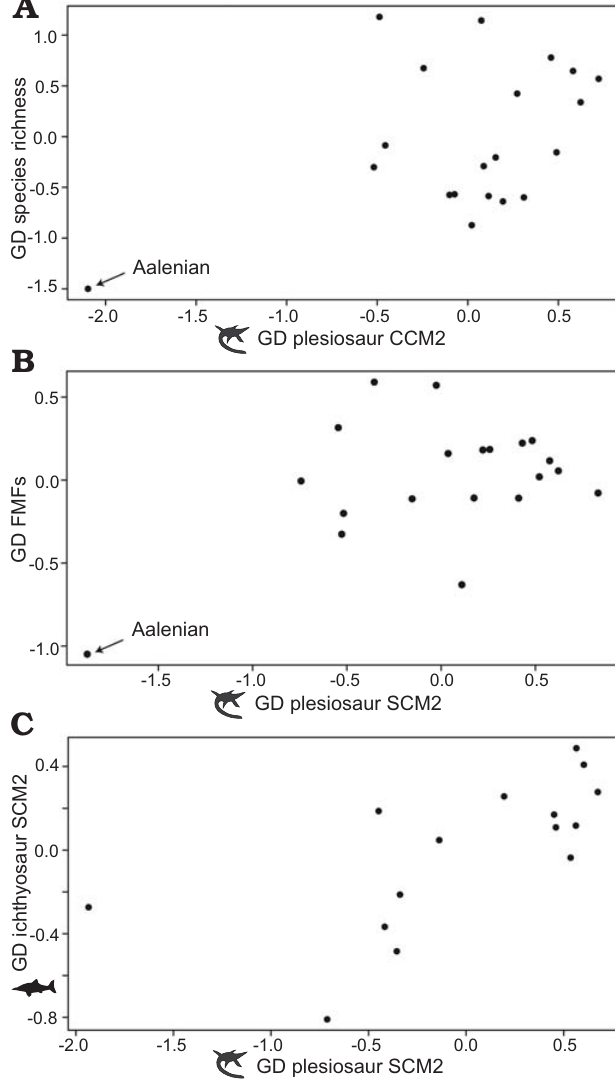
Fig. 3. Scatterplots comparing generalised differenced (GD) plesiosaur CCM2 and SCM2 to GD data for other time series. A . Plesiosaur CCM2 versus species richness. A weak but significant correlation between the two is driven largely by an influential data point, the Aalenian. B . Plesiosaur SCM2 versus fossiliferous marine formations (FMFs). A weak but signif- icant correlation between the two is driven largely by an influential data point, the Aalenian. The scatterplot for CCM2 versus FMFs (not shown) shows a largely identical pattern. C . Plesiosaur SCM2 versus ichthyosaur SCM2. Silhouettes are from phylopic.org, and are credited to Adam Stuart Smith ( Plesiosaurus ) and Gareth Monger ( Ichthyosaurus ). Abbreviations: CCM, character completeness metric; FMF, fossiliferous marine formations; GD, generalised differenced; SCM, skeletal completeness metric (for de- tailed explanation of terms see Completeness metrics in Methods